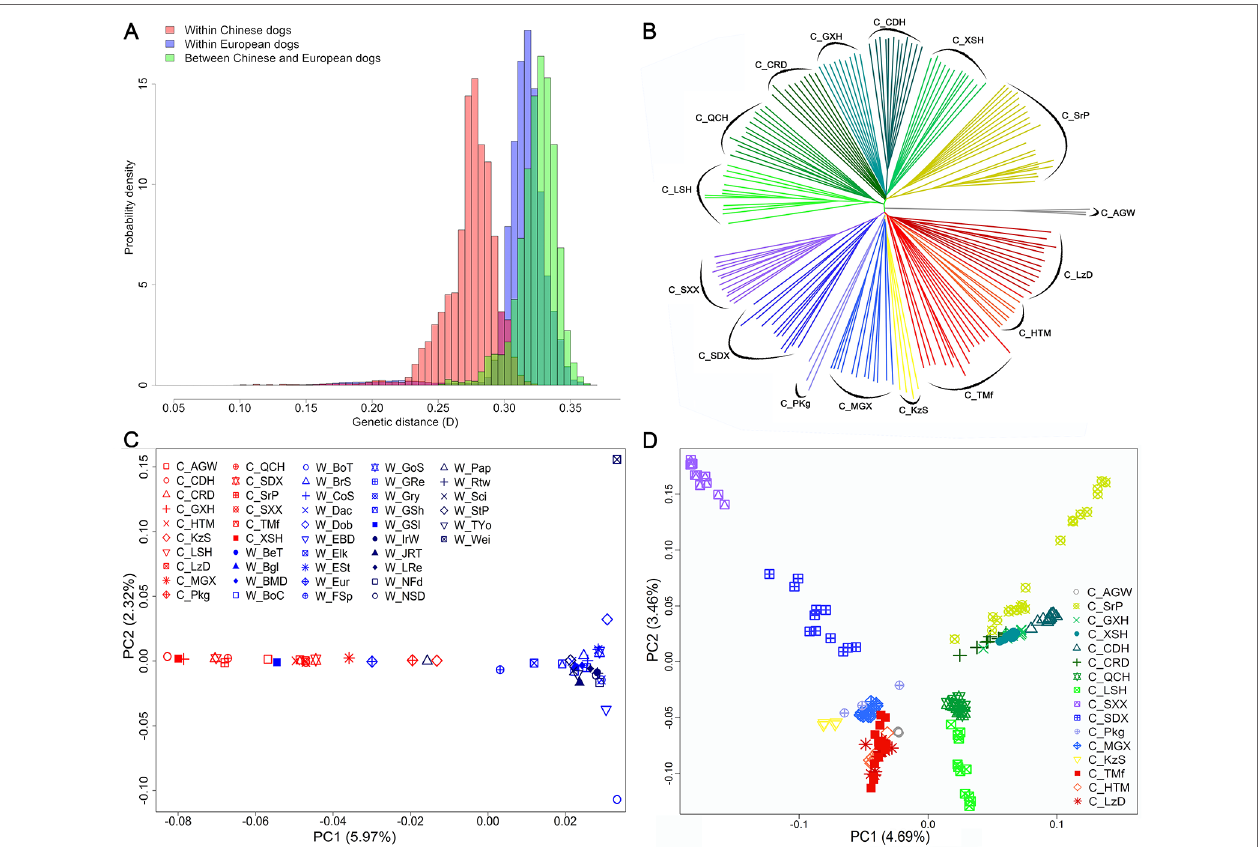
FIGURe 2 | Genetic diversity, and population structures within and between Chinese and Western dogs. (a) The genetic distances between pairs of animals. Light red bars, light blue bars, and light green bars represent genetic distance within Chinese dogs, within Western dogs, and between Chinese and Western dogs, respectively. (B) The neighbor-joining (NJ) tree of the exampled Chinese indigenous dog populations based on genome-wide allele sharing. (C) Population structures of Chinese and Western dogs revealed by principal component analysis. (D) Principal component analysis revealed the population structures of Chinese dogs. Each colorful and shaped point represents a comprehensive value of one breed. The full name of each breed is listed in Table 1